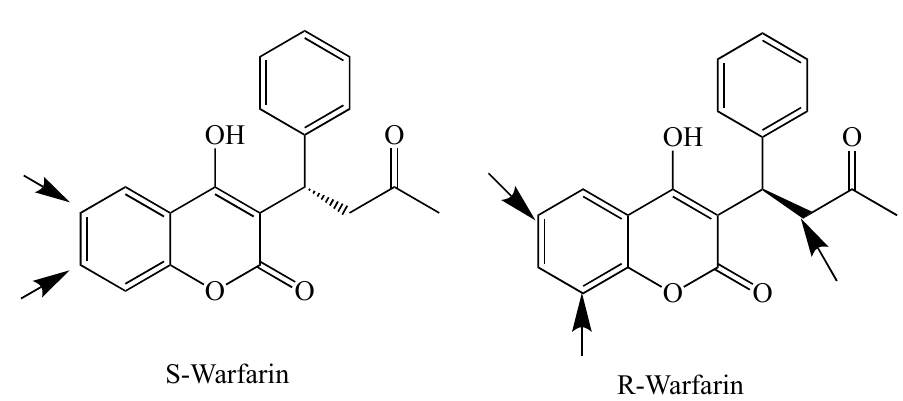
Figure 5. Sites of warfarin hydroxylation by P450s.